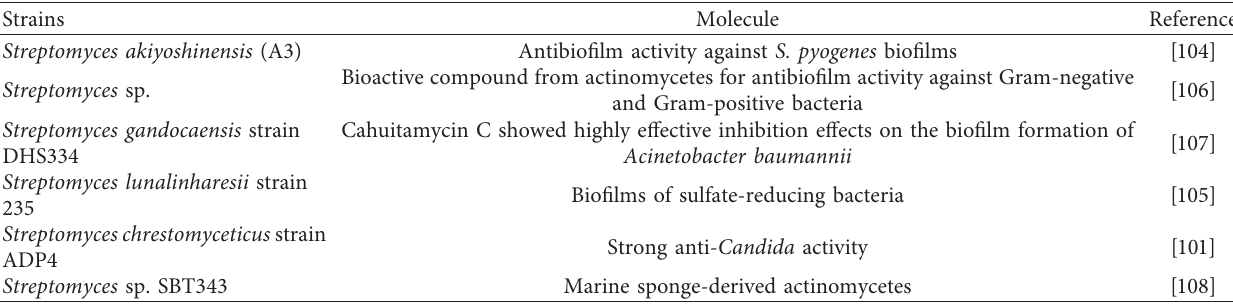
Table 1: Studies conducted on the antibiofilm activities of Streptomyces species.